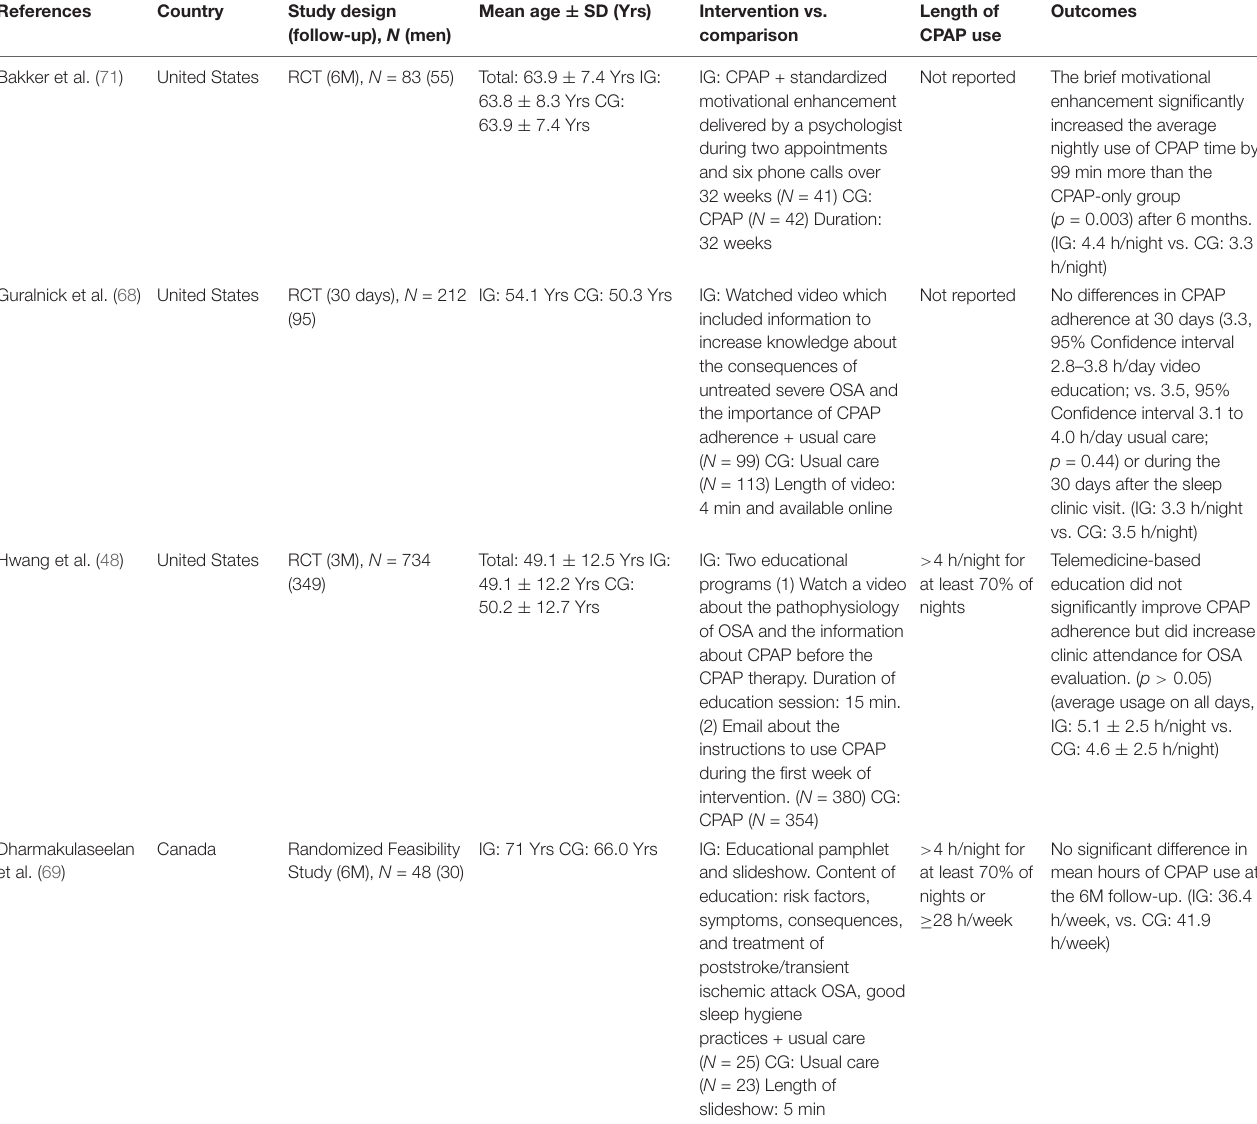
TABLE 3 | Summary of tele-education